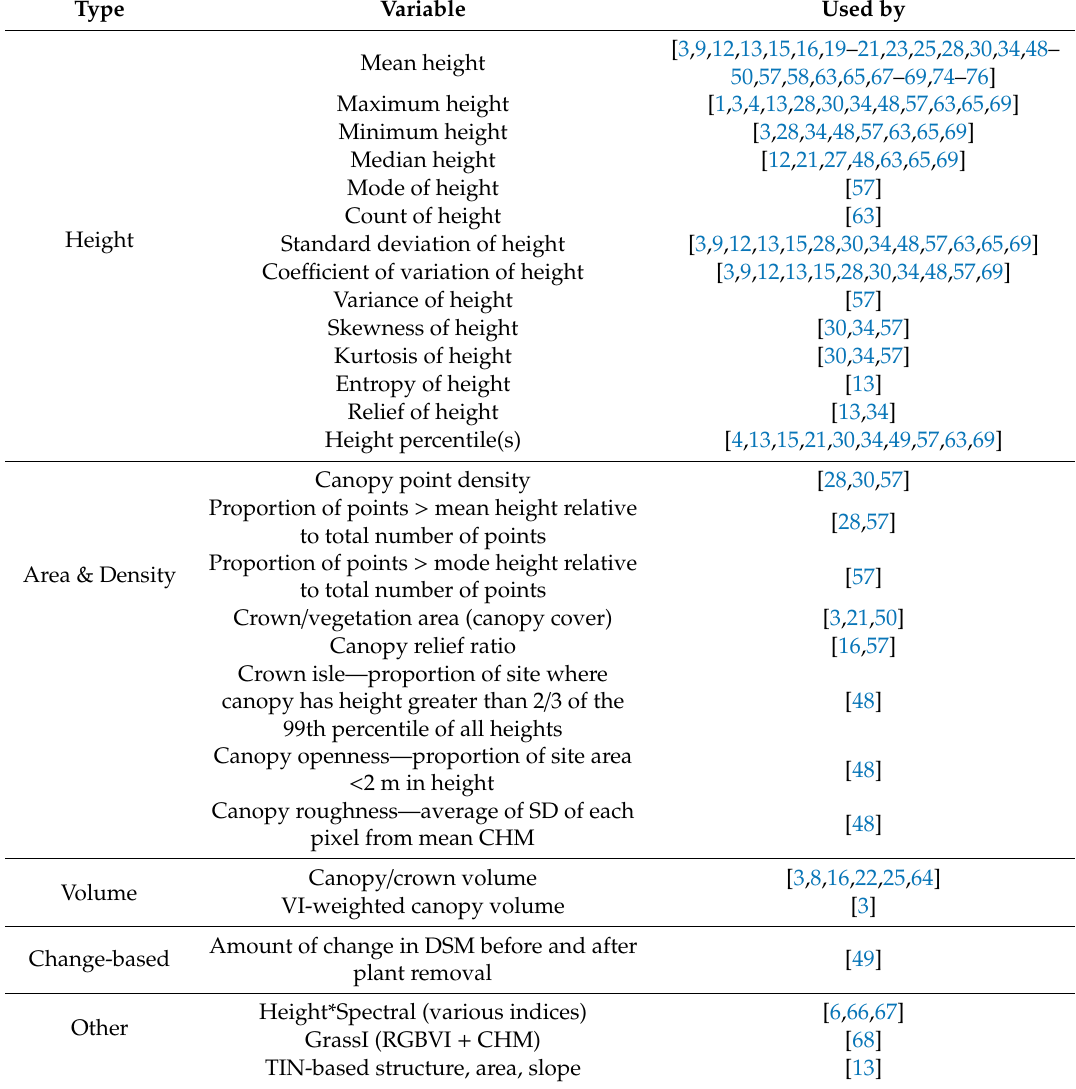
Table 1. Structural information derived from UAS data that was used to model vegetation biomass in at least one study included in this review. Structural metrics could be calculated using individual plant or area-based